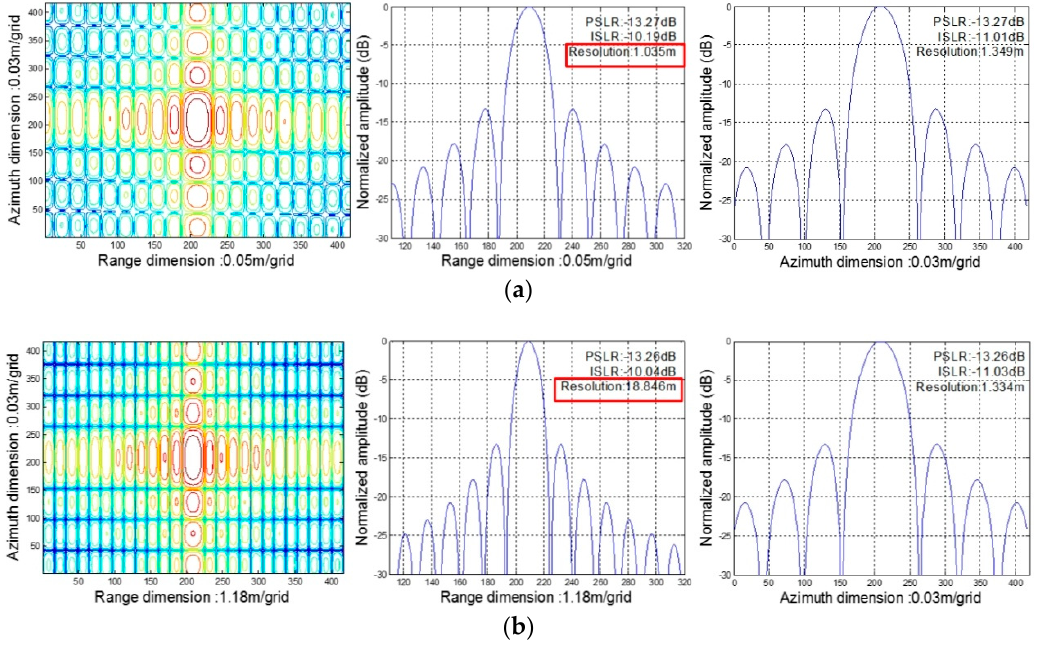
Figure 13. Focusing performances of T 33 when: ( a ) using the parameter adjusting technique; and ( b ) not using the parameter adjusting technique.